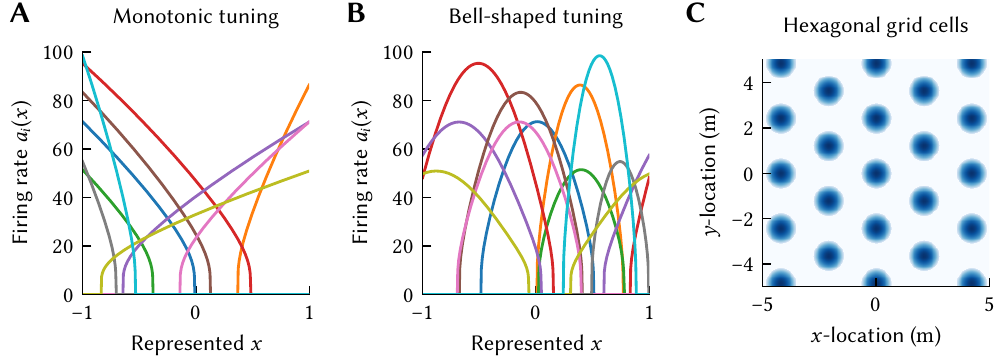
Figure 2. Examples of tuning curves in the linear-nonlinear tuning-curve family with a LIF nonlinear- ity G . ( A ) Using d = 1 results in monotonic tuning over a quantity x . Coloured lines correspond to individual neurons i . ( B ) Bell-shaped tuning-curves can be obtained with d = 2 and transforming x = ( sin ( π x ) ,cos ( π x )) . ( C ) Tuning curve of a single hexagonal grid cell constructed using spatial semantic pointers (SSPs) with d = 7 (deep blue corresponds to a firing rate of